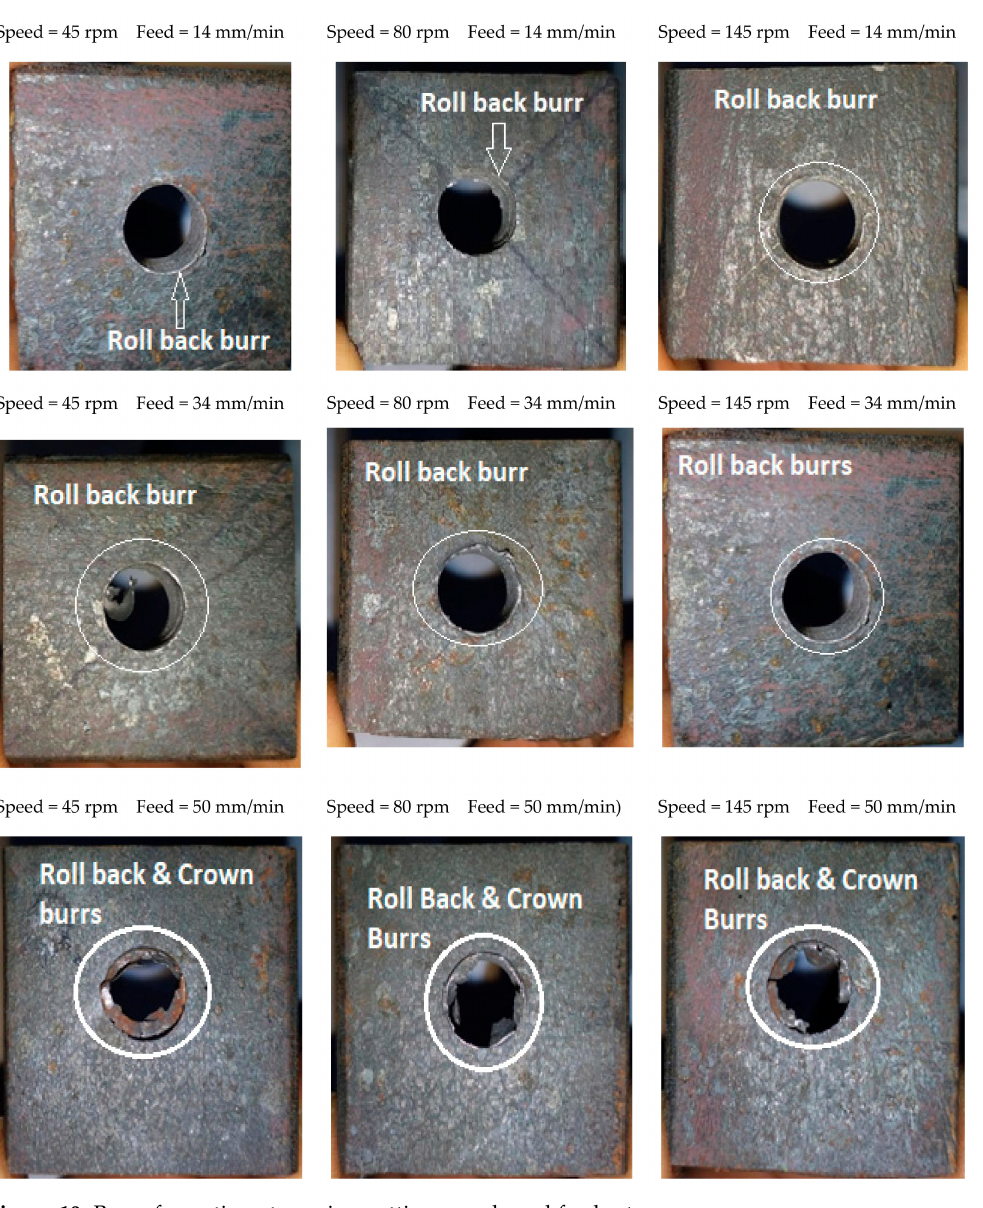
Figure 10. Burrs formation at varying cutting speeds and feed